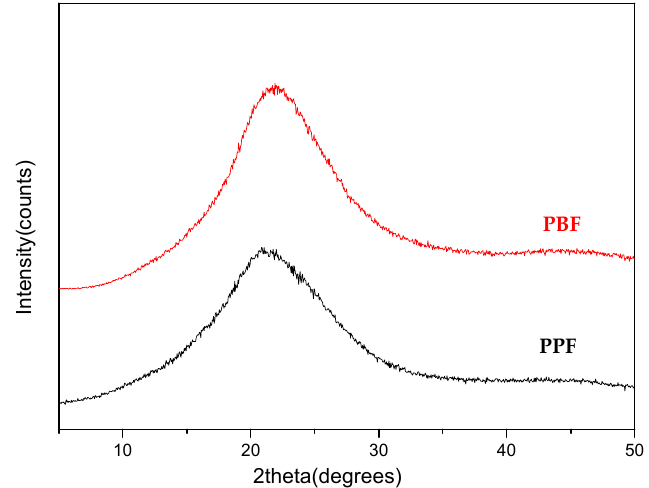
Figure 2. WAXD patterns of the prepared poly(propylene furanoate) and poly(butylene furanoate) polyesters after melt polycondensation procedure.